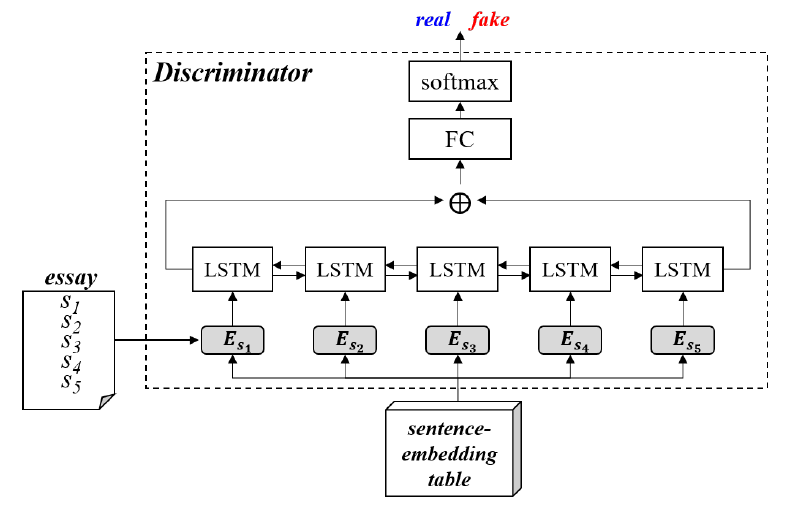
Figure 2. The architecture of the discriminator used in